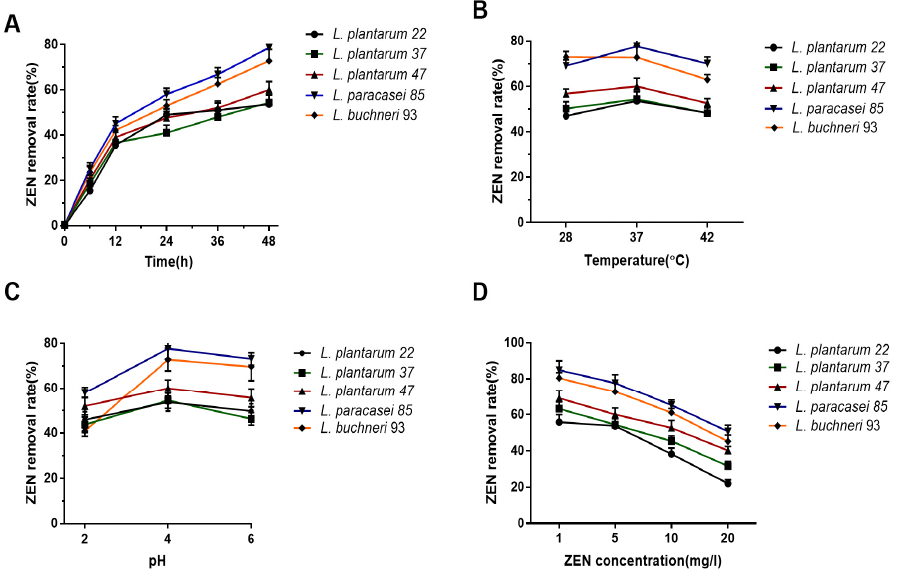
Figure 2. Optimization conditions of LAB incubation to promote the ZEN removal potential. ( A ) The effect of incubation time (6, 12, 24, 36, and 48 h) on the ZEN removal ability. ( B ) The effect of incubation temperature (28, 37, and 42 °C) on the ZEN removal ability. ( C ) The effect of pH media (2.0, 4.0, and 6.0) on the ZEN removal ability. ( D ) The effect of ZEN concentration (1, 5, 10, and 20 mg/L) on the ZEN removal ability.